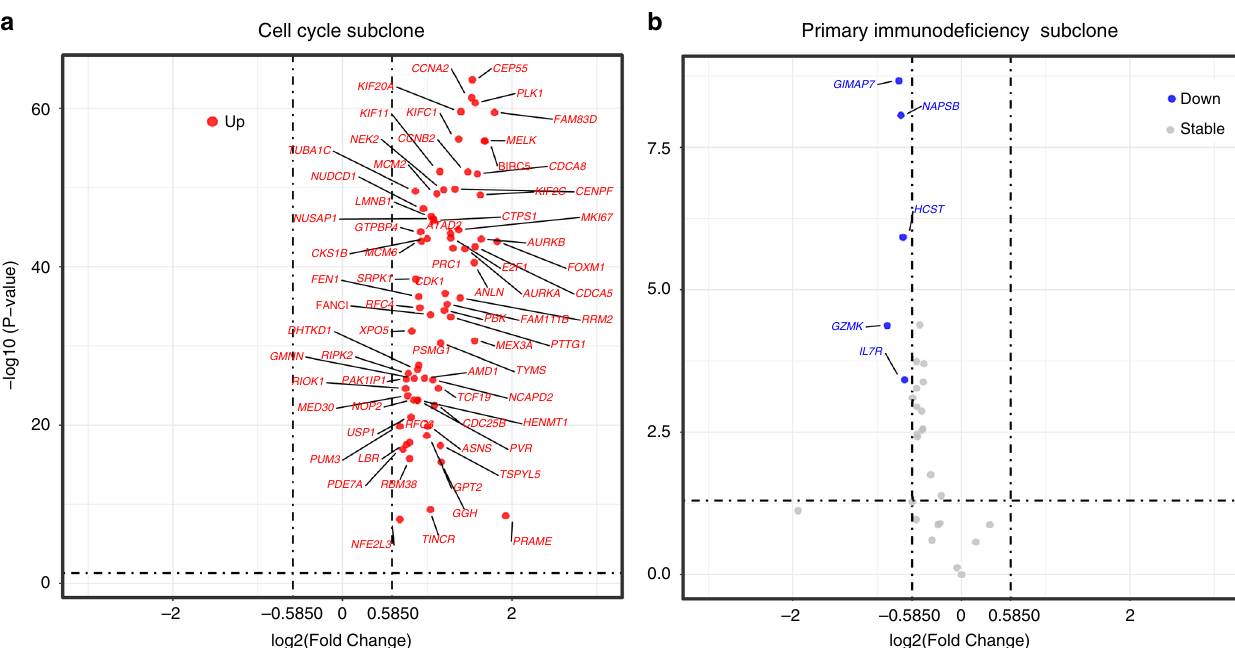
Fig. 5 Illustration of differentially expressed genes of subclones between the poor-survival and good-survival groups. Volcano plots are shown for the cell cycle ( a ) and primary immunode fi ciency ( b ) subclones. Source data are provided as a Source data fi